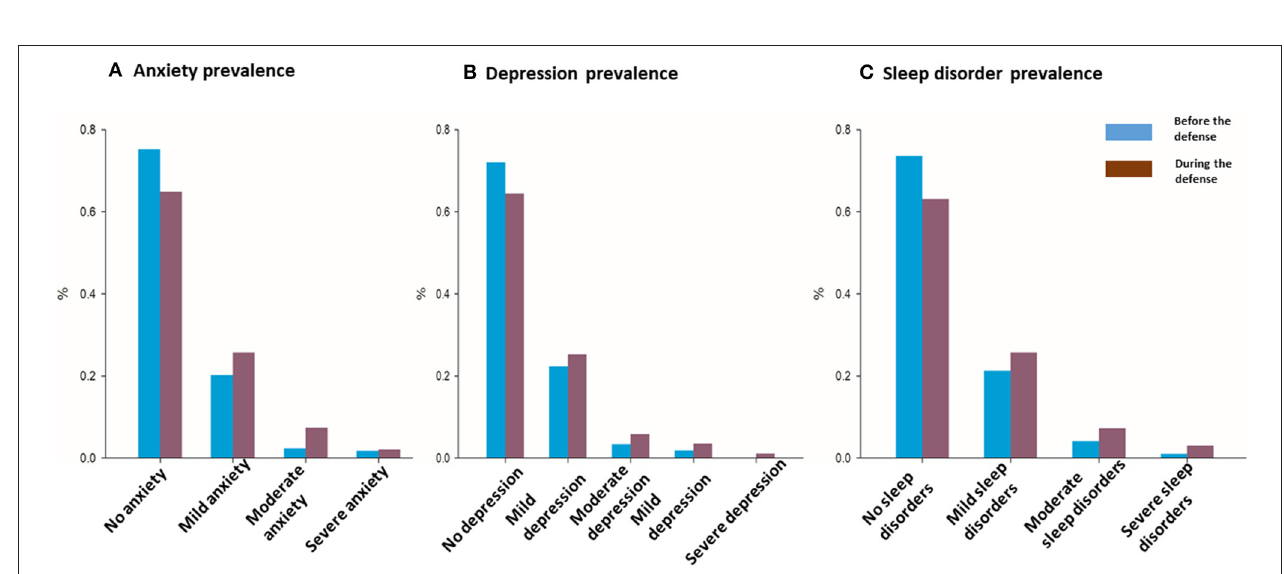
FIGURE 2 | Psychological symptom percentage and anxiety incidence distribution.